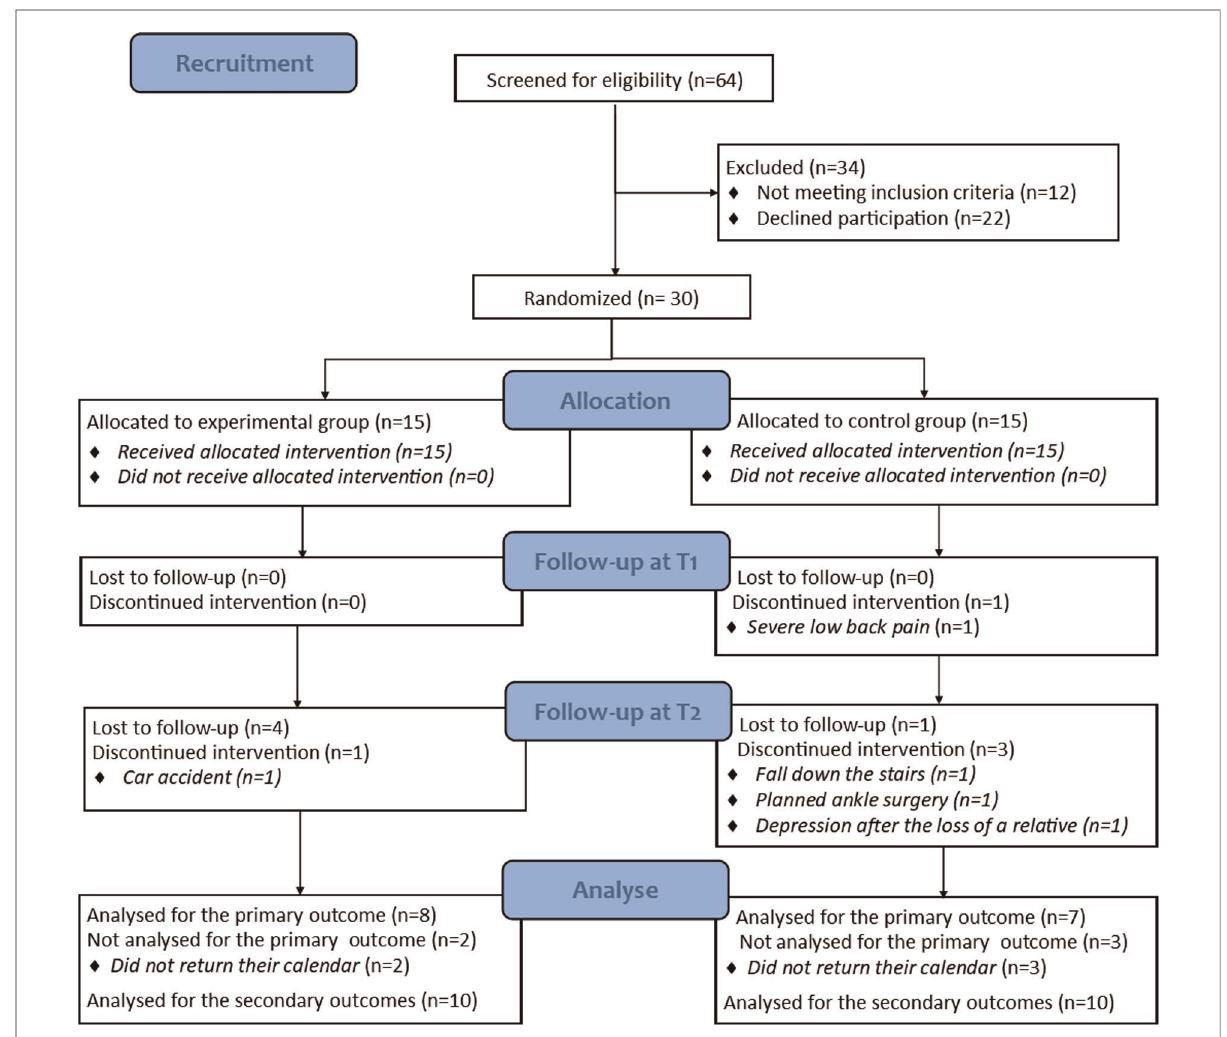
FIGURE 1 CONSORT participants fl ow diagram.